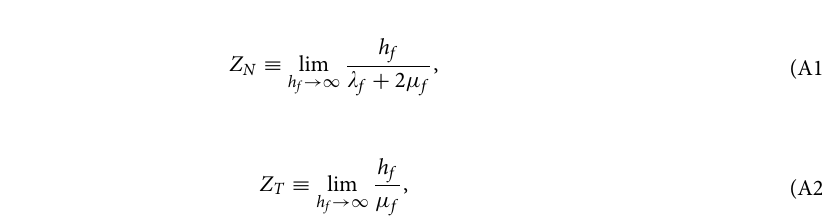
where h f denotes the thickness fraction of fractured layer, and (cid:31) f and µ f are the first and second Lamé constants of fractured layer. Then the normal and shear fracture weaknesses ( δ N and δ T ) can be expressed as